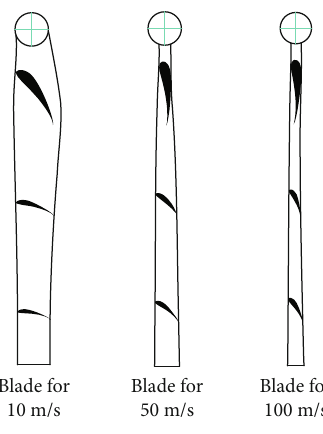
Figure 5: Cross-section of the blade for three di ff erent